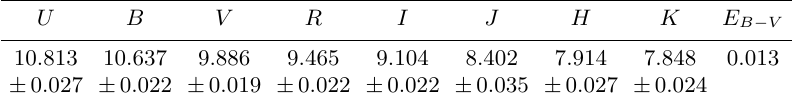
Table 3. Intrinsic UBVRIJHK magnitudes of BD+20